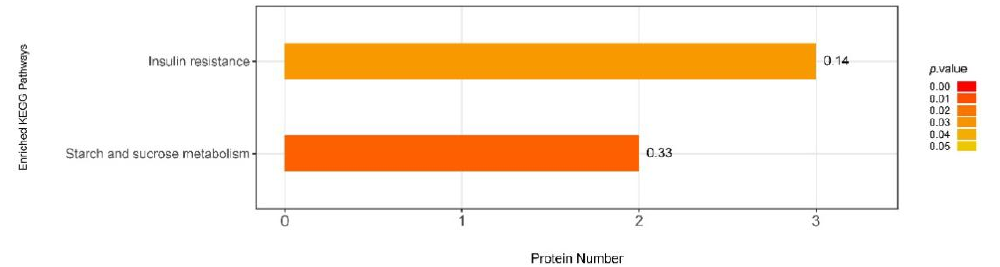
Figure 10. KEGG enrichment analyses of all differentially abundant proteins ( p -value of Fisher’s exact test <